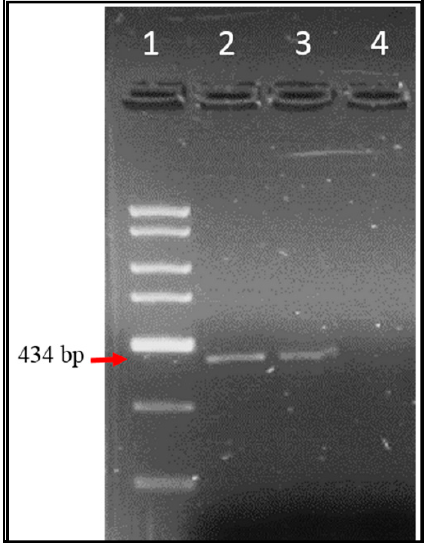
Figure 3. Agarose gel electrophoresis of enterovirus RT-PCR products from Tubli WPCC influent and e ffl uent sewage samples. Lane 1: 2 Kb DNA ladder, lane 2: EV amplicon (434 bp) from influent sewage sample, lane 3: EV amplicon (434 bp) from e ffl uent sewage sample, lane 4: negative control of